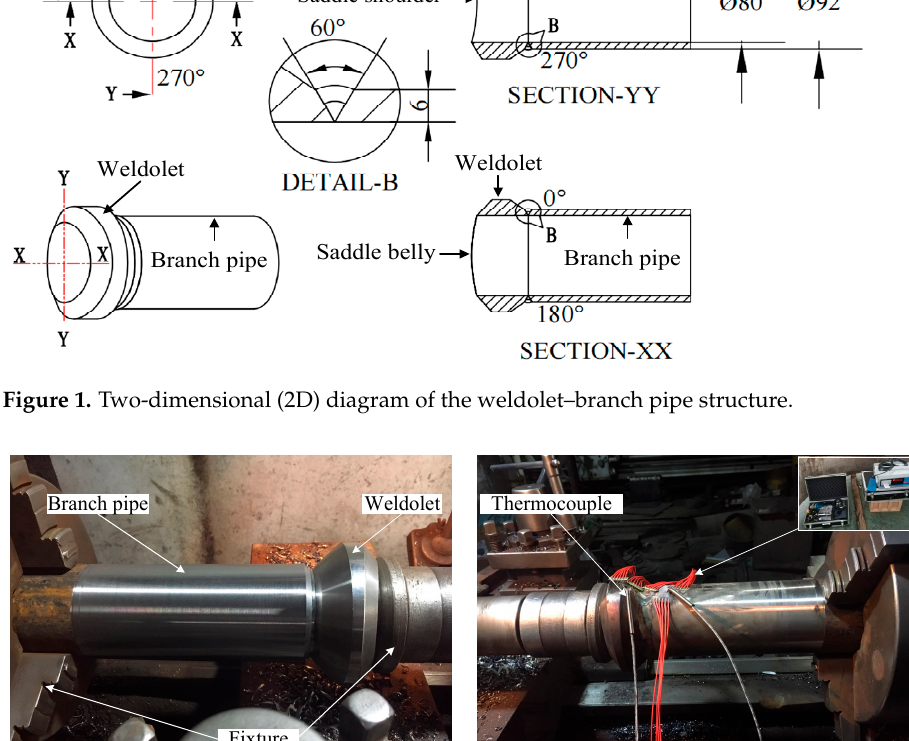
Figure 1. Two ‐ dimensional (2D) diagram of the weldolet–branch pipe structure. During the welding process, no external constraints are imposed on the components,